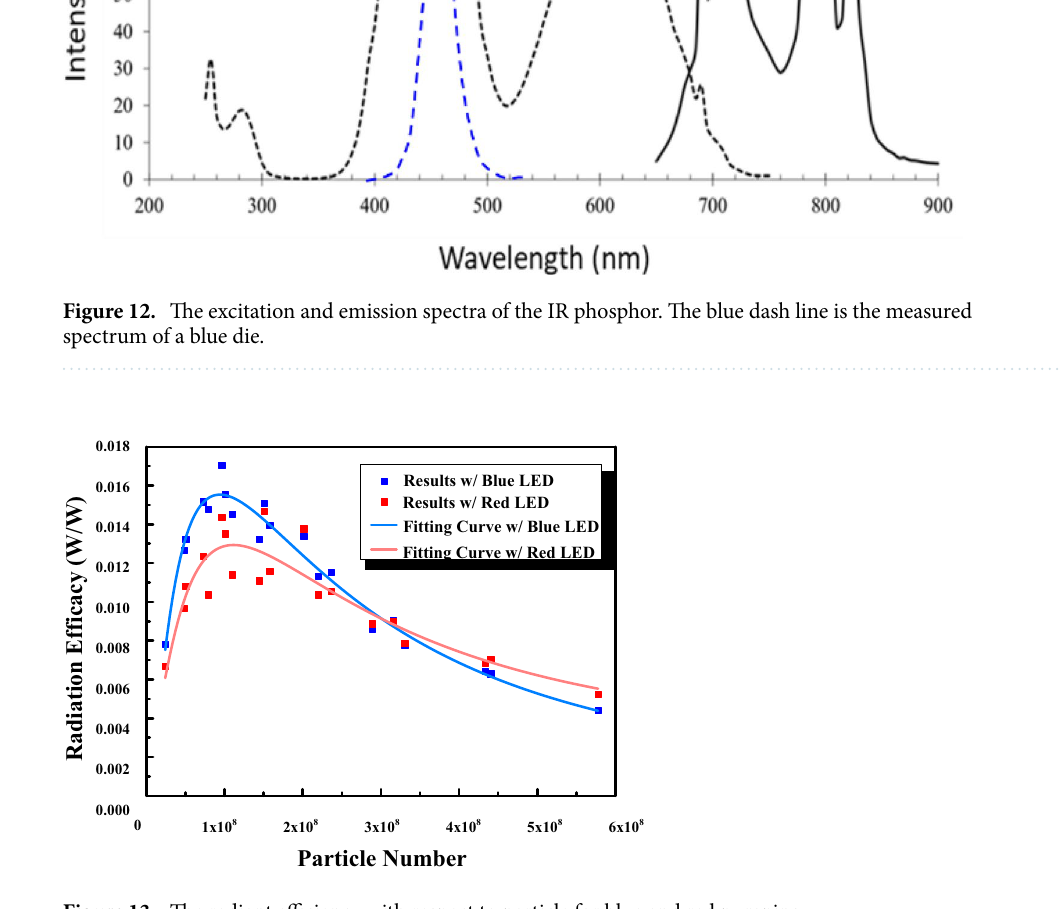
Figure 13. The radiant efficiency with respect to particle for blue and red